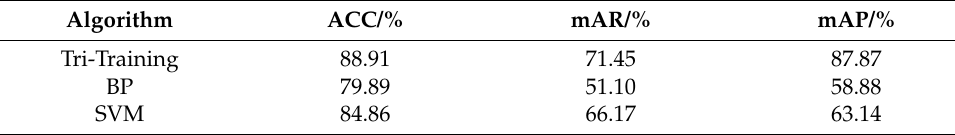
Table 4. Radar recognition evaluation